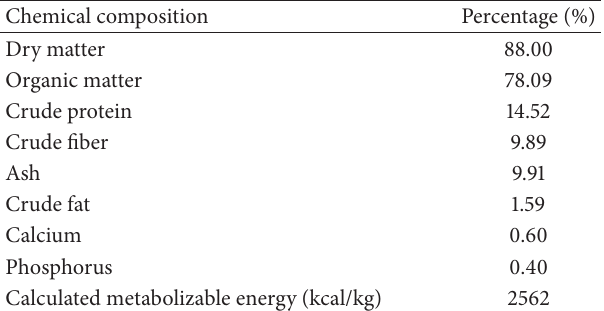
Table 1: Chemical composition of the concentrate feed (%). Chemical